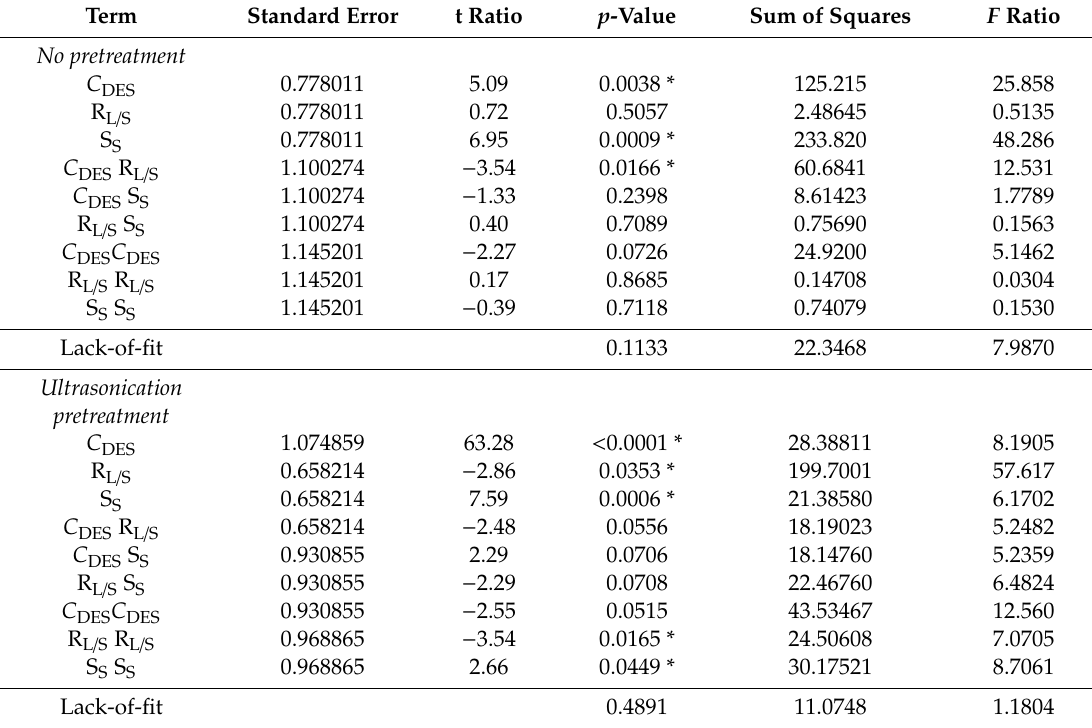
Table 2. Statistical data obtained after implementing response surface methodology.